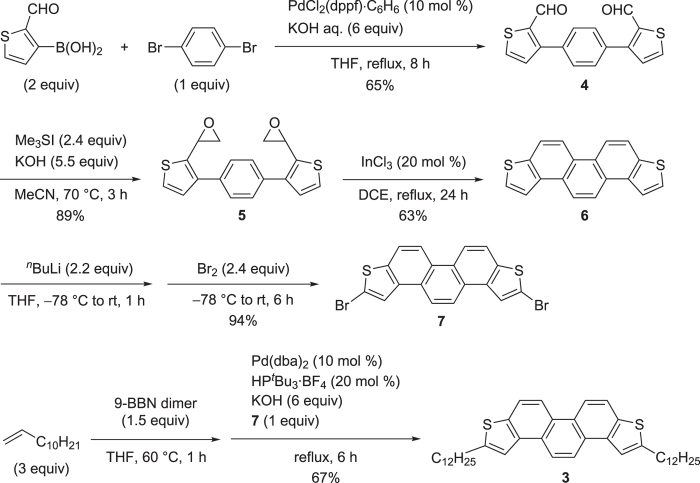
Synthetic procedure of (C12H25)2-i-PDT 3.